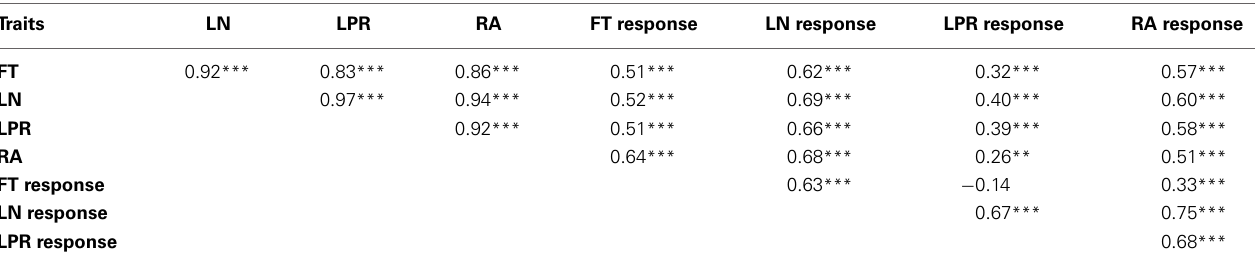
Table 1 | Pearson’s correlation coefficients ( r ) for flowering time, three growth related traits and their relative responses to water deficit in the L er x An-1